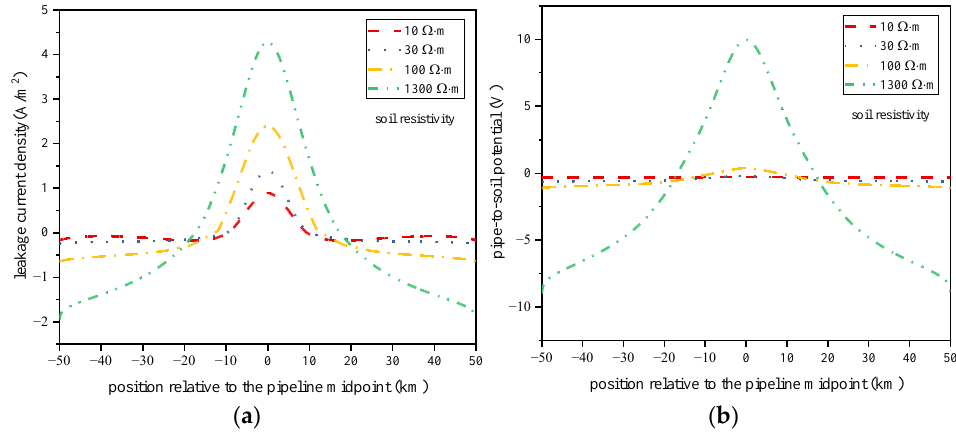
Figure 15. Calculation results under different soil resistivity. ( a ) leakage current density along the pipeline; ( b ) PSP along the pipeline.